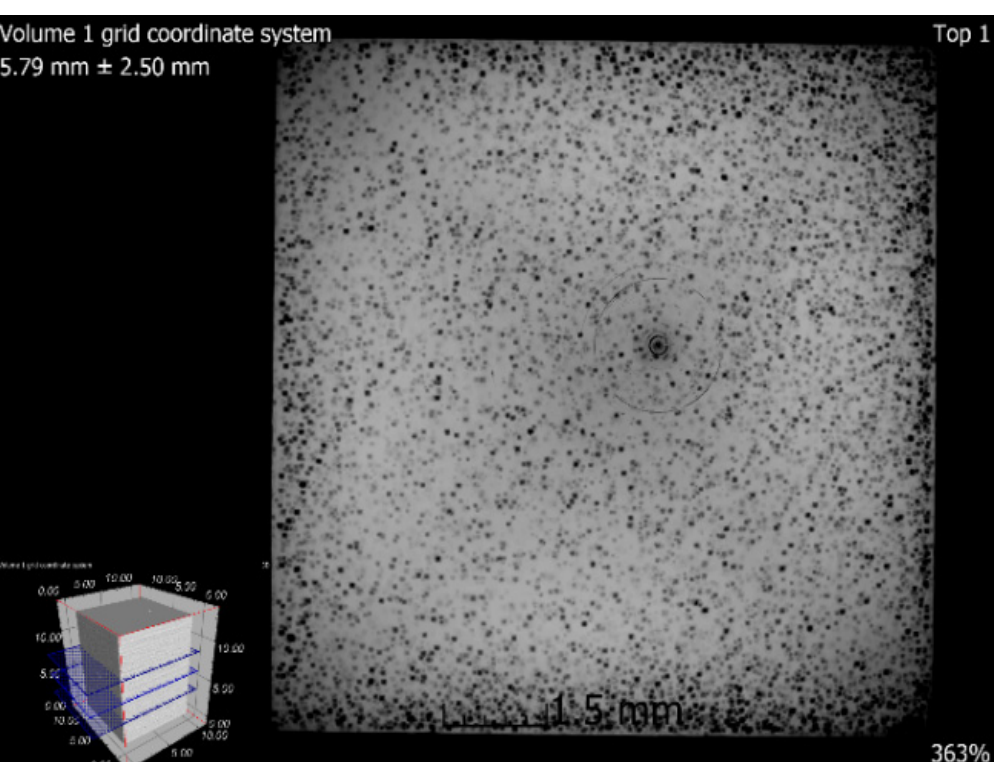
Figure 17. Tomographic CT sections of sample 5 after SLM (XZ plane).